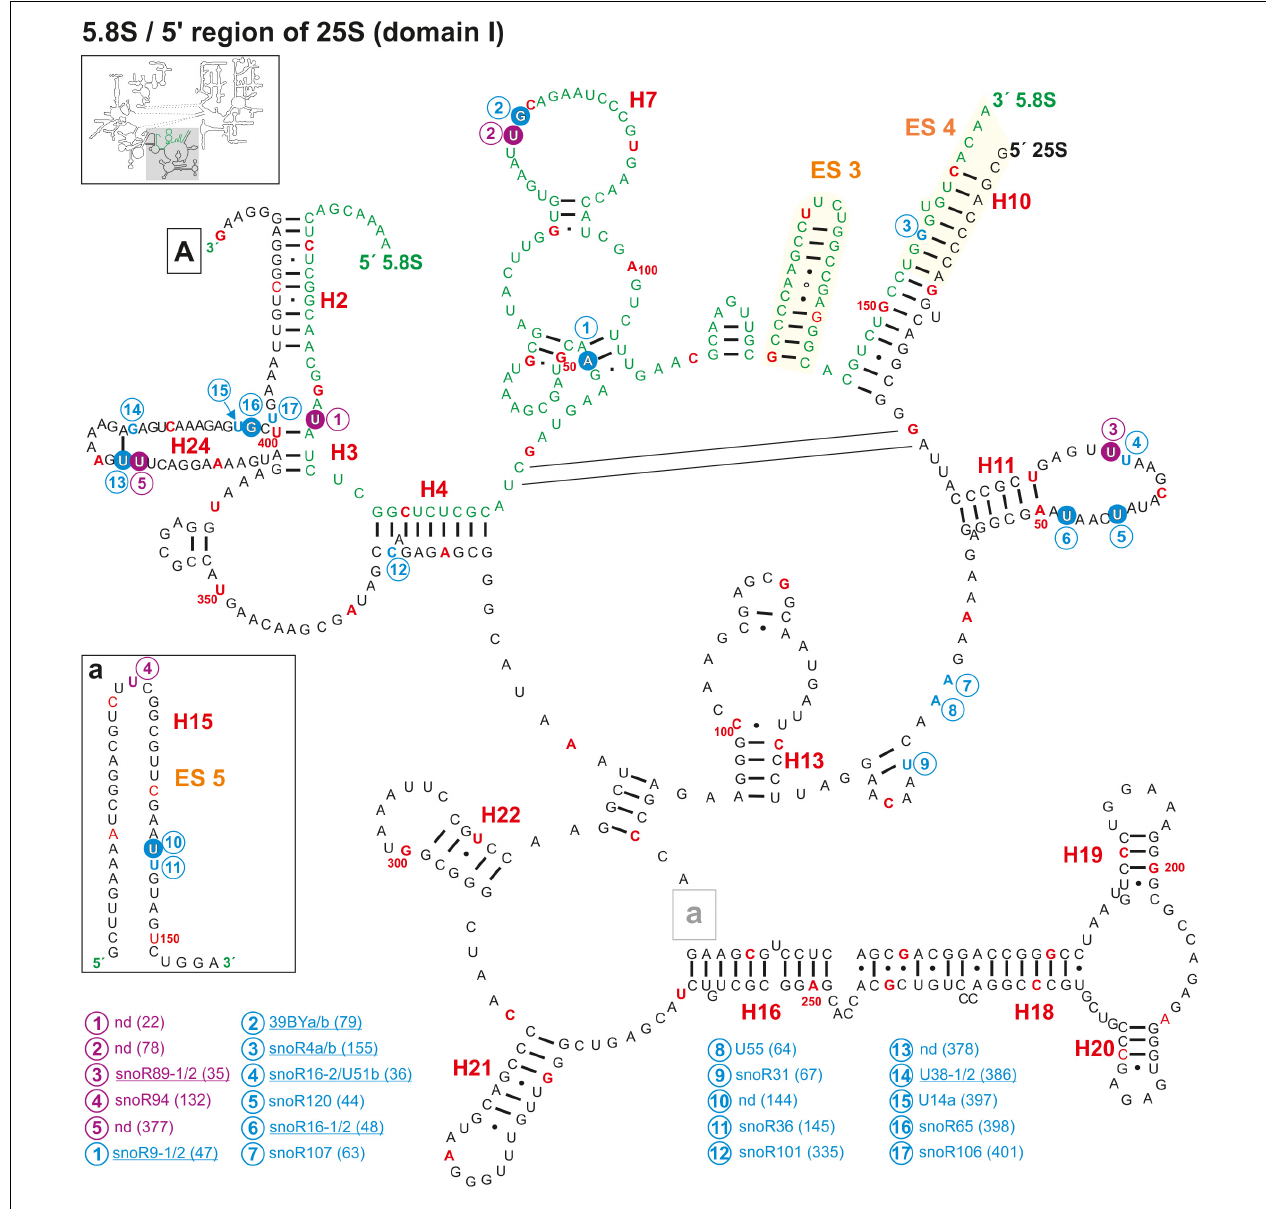
FIGURE 3 | Secondary structure diagram of the 5.8S rRNA and domain I of 25S rRNA of A. thaliana . There is no experimental determined secondary structure map of the rRNA of A. thaliana . Hence, the secondary map of 5.8S (letters in green) and 25S (letters in black) was created based on the RNAcentral database (The RNAcentral Consortium, 2019) and http://www.rna.icmb.utexas.edu. The positions for predicted (blue letter) and verified 2 (cid:48) -O-ribose-me (white letter in blue circle) sites and the predicted (violet letter) and verified positions for pseudouridylation (white letter in violet circle) are shown. If several snoRNAs are annotated to target